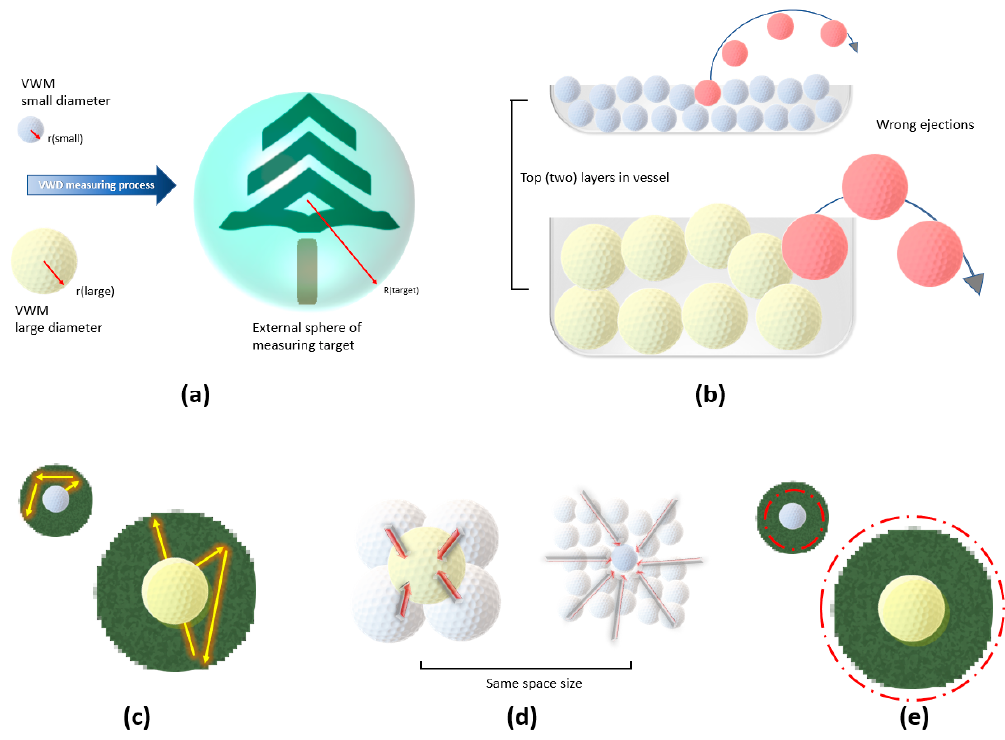
Figure 16. Demonstration graph for scale effect and random movement of VWMs in micrographic scale. ( a ) VWD process on the same measuring target using small and large VWMs. ( b ) The wrong ejection occurred in the top (two) layers of the vessel. ( c ) Randomly accessed region around the center of VWM. ( d ) Source of forces that applied to the VWMs (in the center). ( e ) Adjusted randomly accessed region (the red circle) by the consideration of the source of forces.